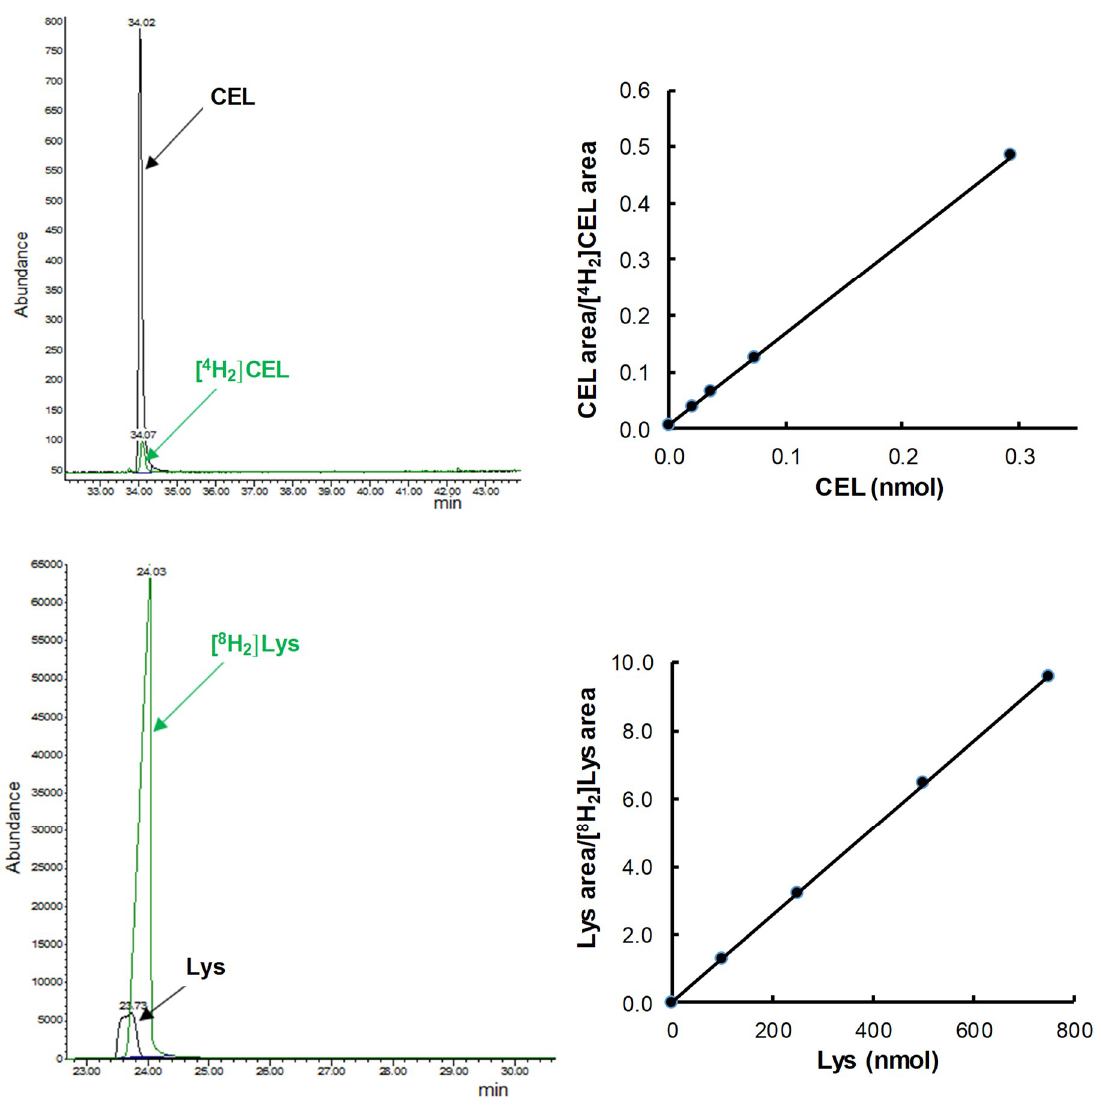
Figure 1. Chromatograms and correlation curves of biomarkers of protein oxidative modifications. Deuterated (green) and non-deuterated (black) compounds were detected in SIM mode. Standard curves with linear correlation coefficients higher than 0.998 were derived from the analyses. HAVA ([ 2 H 5 ]-5-hydroxy-2-aminovaleric acid) and HACA ([ 2 H 4 ]-6-hydroxy-2-aminocaproic acid) are the compounds directly detected by GC/MS after sample processing according to Mat and Meth, and correspond to GSA (glutamic semialdehyde) and AASA (aminoadipic semialdehyde), respectively. CML: N -(carboxymethyl)lysine; CEL: N -(carboxyethyl)lysine.